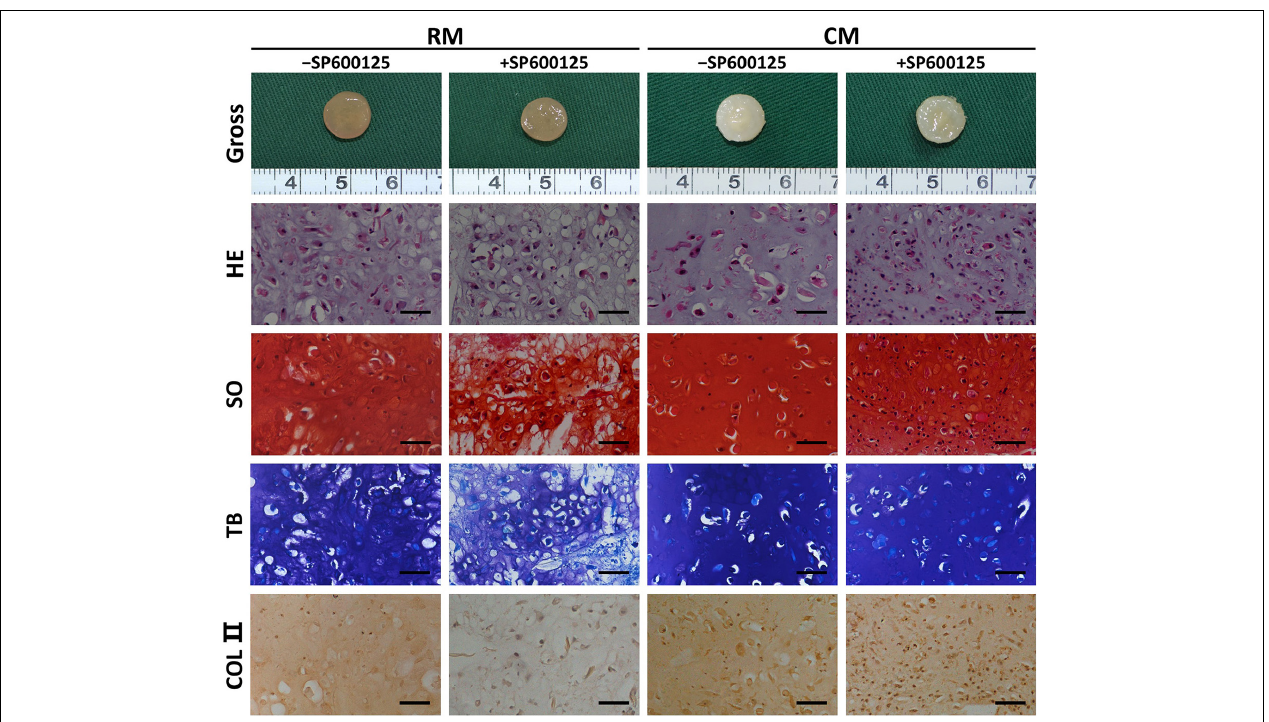
FIGURE 5 | Gross view and histology of in vitro cartilage regeneration. Samples in different groups showed different colors and textures. The CM groups showed more mature cartilaginous tissue and increased ECM production than did the RM groups. Treatment with SP600125 alone decreased the ECM deposition and cartilage maturity with weak staining for cartilage-specific ECM molecules. However, the CM + SP600125 culture reversed the effect of SP600125 alone in reducing ECM synthesis and produced more active cells with stained nuclei compared with the -SP600125 groups at the same time. Scale bars = 50 µ m. SO, Safranin O staining; TB, toluidine blue staining; COL II, type II collagen staining; RM, regular medium; CM, chondrogenic medium; and ECM, extracellular